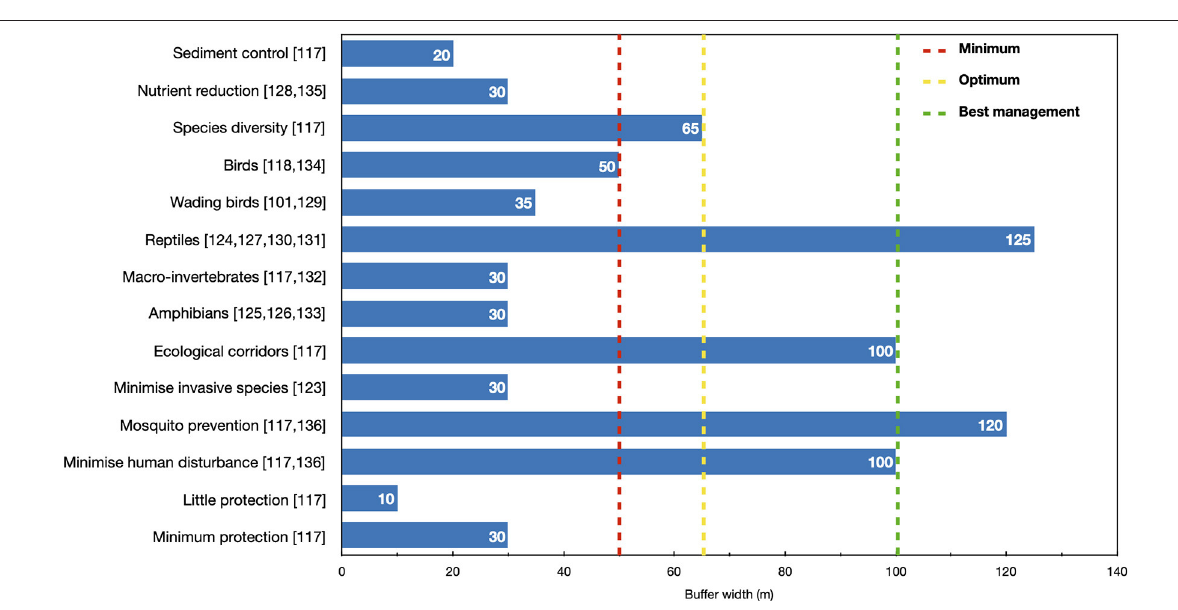
FIGURE 6 | Range of buffer widths for providing specific buffer function from literature and minimum (red, 50m), optimum (yellow, 65m), and best management (green, 100m) from wetland buffer zone policy (Western Australian Planning Commission, 2005). Adapted from Castelle et al.